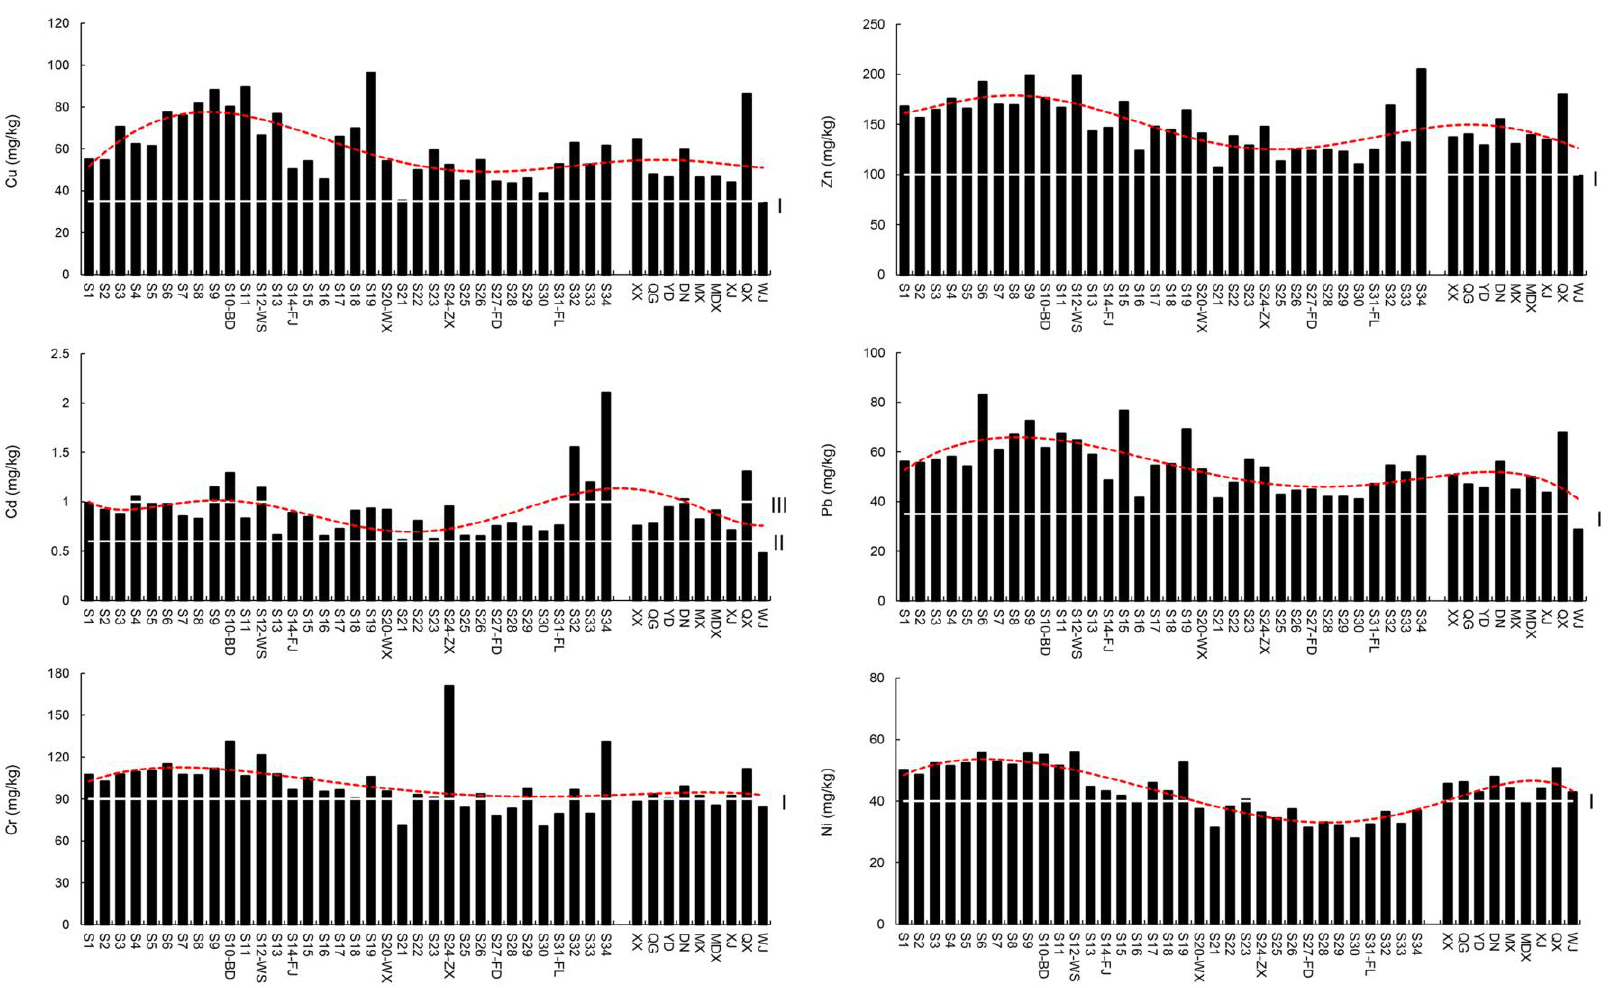
Figure 4. Spatial distribution of Cu, Zn, Cd, Pb, Cr, and Ni in the Three Gorges Reservoir. The white lines represent the standard values of the soil (GB 15618-1995).